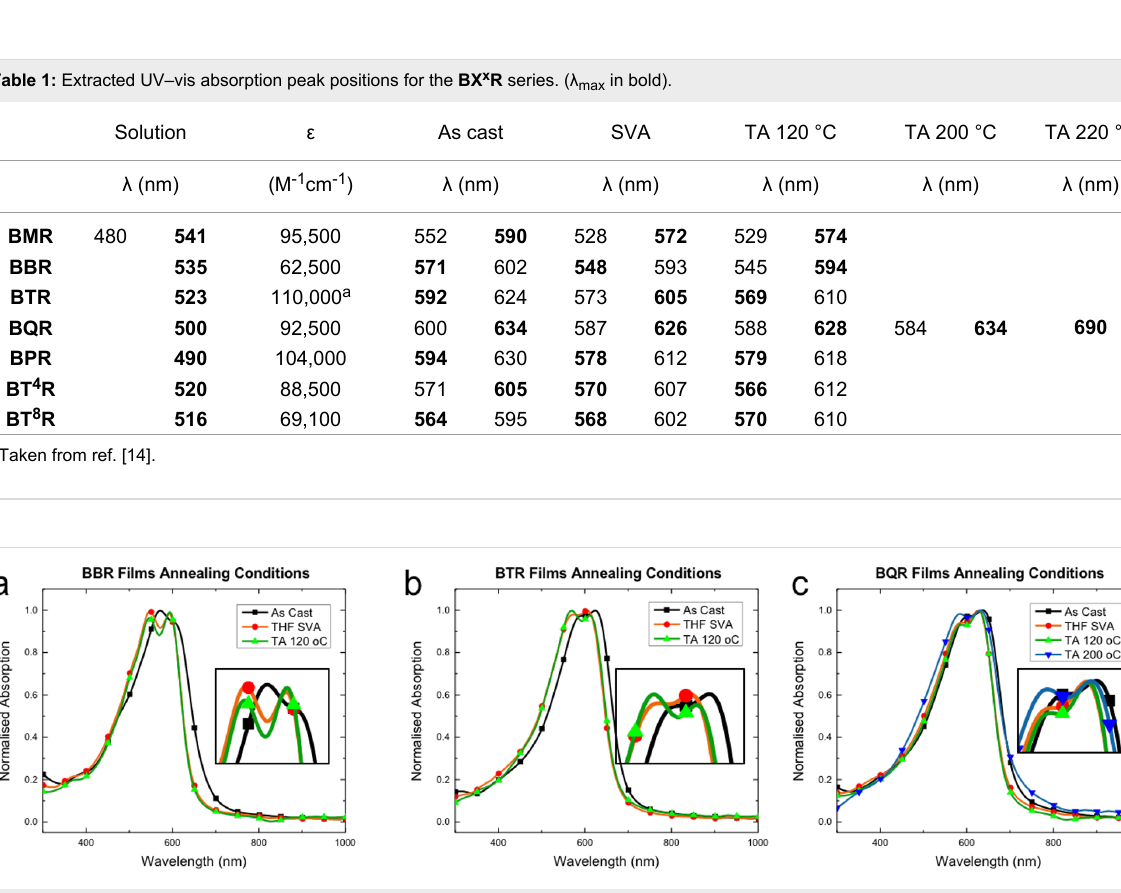
Figure 6: Normalised thin film UV–vis absorption profiles for a) BBR , b) BTR and c) BQR showing as-cast (black, square), SVA with THF for 10 s (orange, circle) and thermally annealed (TA) at 120 °C for 10 minutes (green, triangle). Insets show expansion of the main peak area.